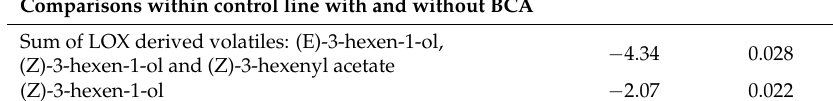
Table 1. Significant differences in volatile amounts from the barley OeLOX2.2 line and its control line with and without BCA. Volatiles were collected during 48 h. Analysis by two-way ANOVA with “line” and “aphids” as fixed factors, followed by Tukey B as a post-hoc test ( n = 6). Comparisons between Plants with and without BCA Difference p -Value Sum of LOX derived volatiles: (E)-3-hexen-1-ol, (Z)-3- 0.049 hexen-1-ol and (Z)-3-hexenyl acetate (Z)-3-hexen-1-ol 0.029 β -Caryophyllene 0.044 Linalool 0.046 Comparisons within control line with and without BCA Sum of LOX derived volatiles: (E)-3-hexen-1-ol, (Z)-3- − 4.34 0.028 hexen-1-ol and (Z)-3-hexenyl acetate (Z)-3-hexen-1-ol − 2.07 0.022